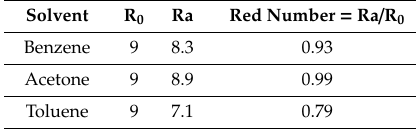
Table 6. Relative energy di ff erence (RED) of trimethylamine for organic solvent.